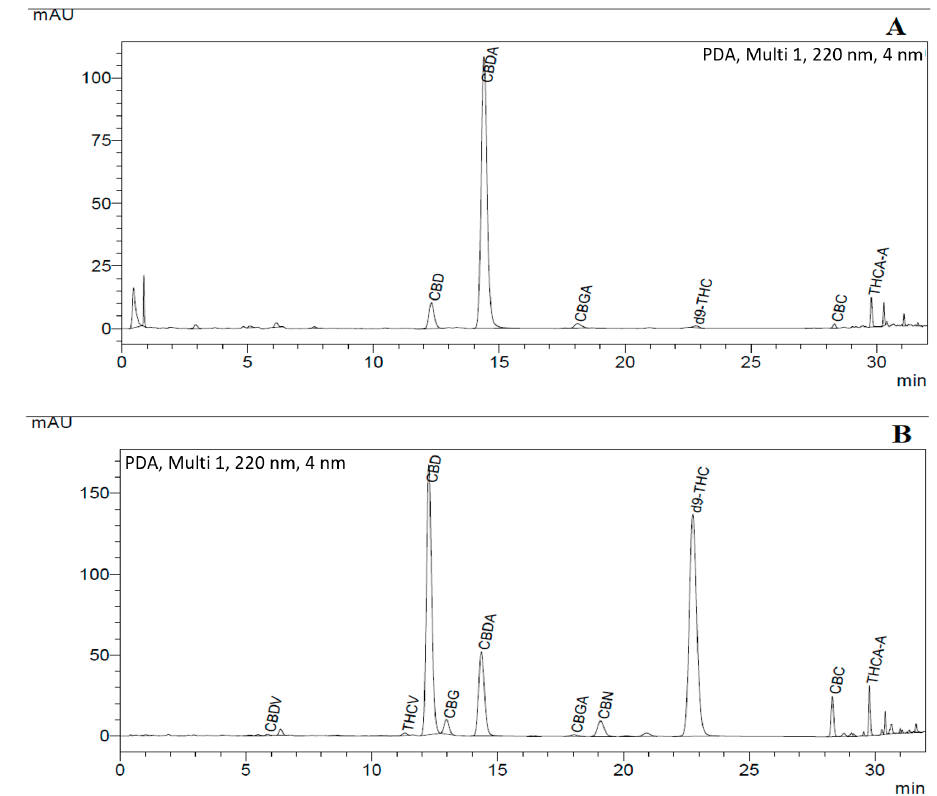
Figure 11. uHPLC profile of cannabis strains: ( A ) with dominant CBD + CBDA (around 90% w/w ); and ( B ) with 55% w/w CBD+CBDA and 45% THC + THCA in the cannabinoid mixture. Table 5. Amount of cannabinoids in the SCF extract of two different cannabis strains. CBD µg/mL Cannabinoids (±S.E.M)